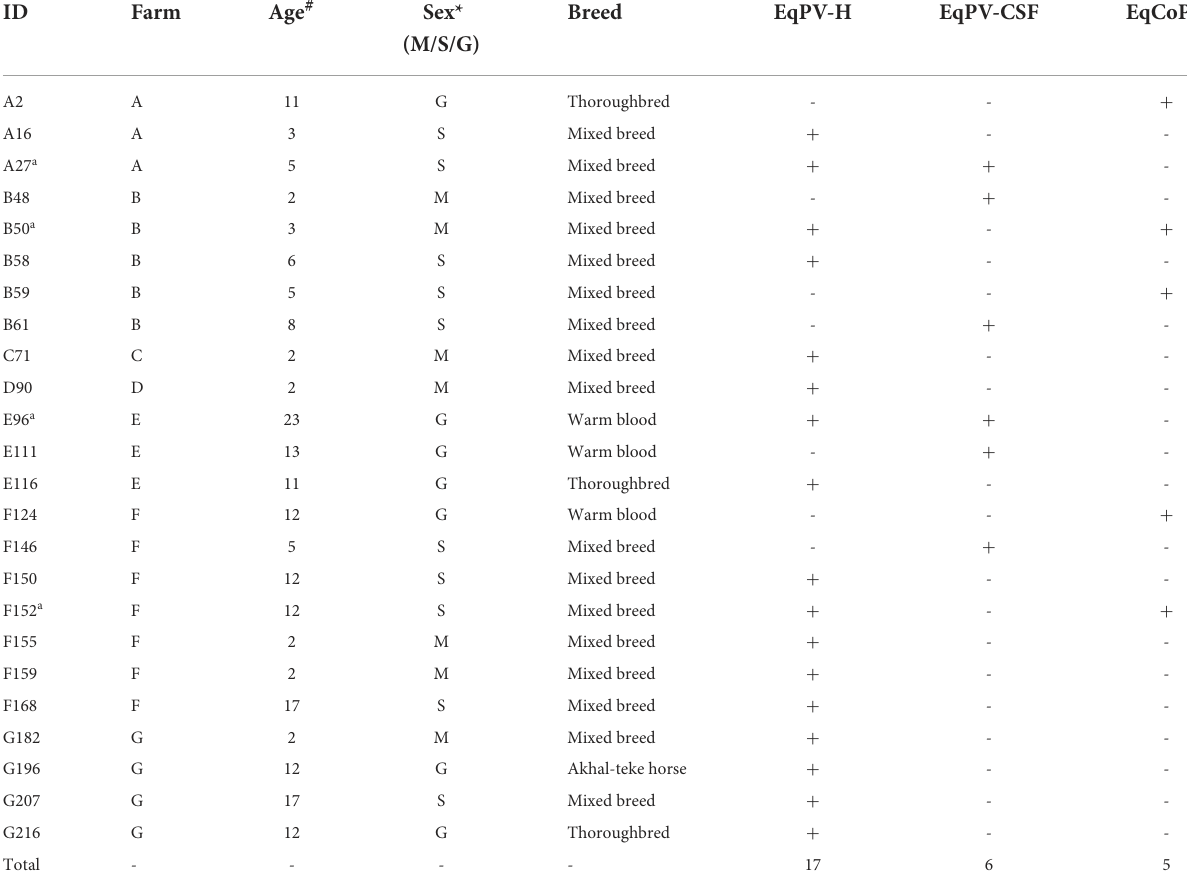
TABLE 3 Characteristics of horses whose serum samples contained EqPV-H, EqPV-CSF and/or